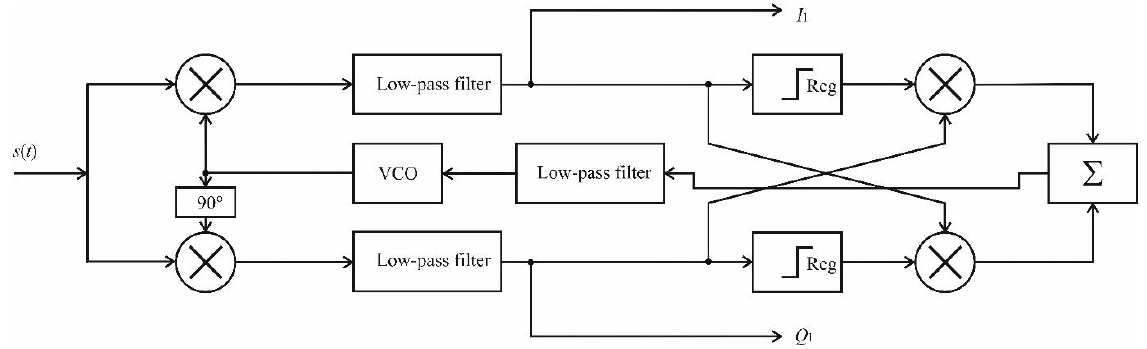
Fig. 4. Structural block diagram of carrier recovery for QPSK signal based on Costas loop (VCO is voltage controlled generator; Reg is regenerator).